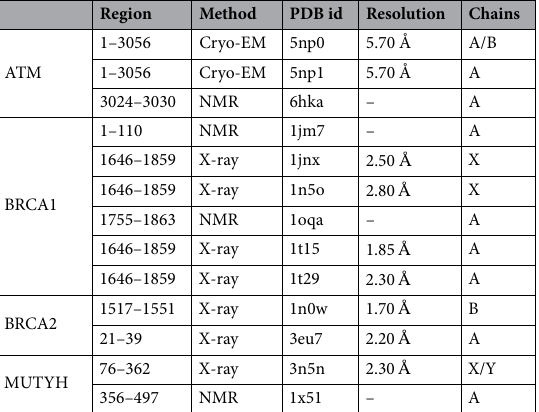
Table 5. List of the 3D structures of the key DDR proteins available from the PDB